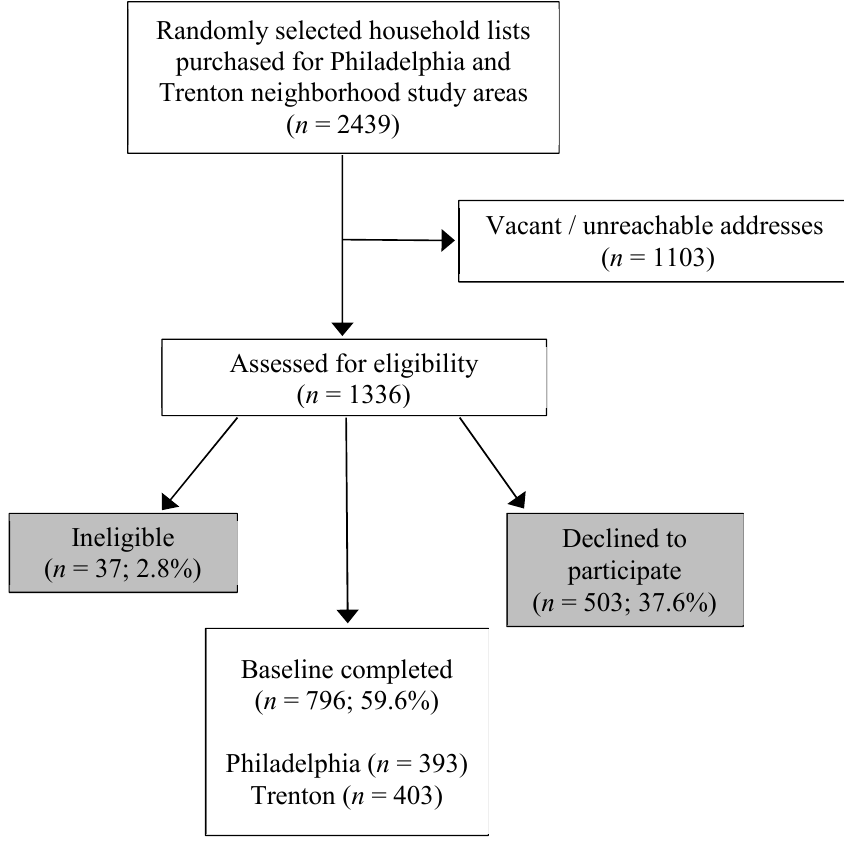
Figure 1. Selection Process for the Food in Our Neighborhood (FIONS) Study Sample.